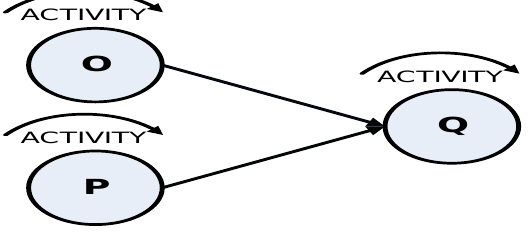
Figure 4. Activity Q cannot take place until activities O and P are